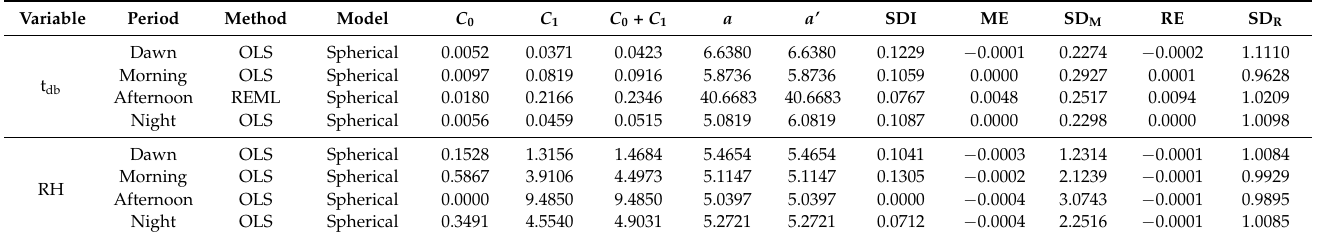
Table 3. Methods, models, and parameters estimated from the semivariograms adjusted for dry-bulb air temperature (t db ), relative humidity (RH), temperature and humidity index (THI), and specific enthalpy of air ( h